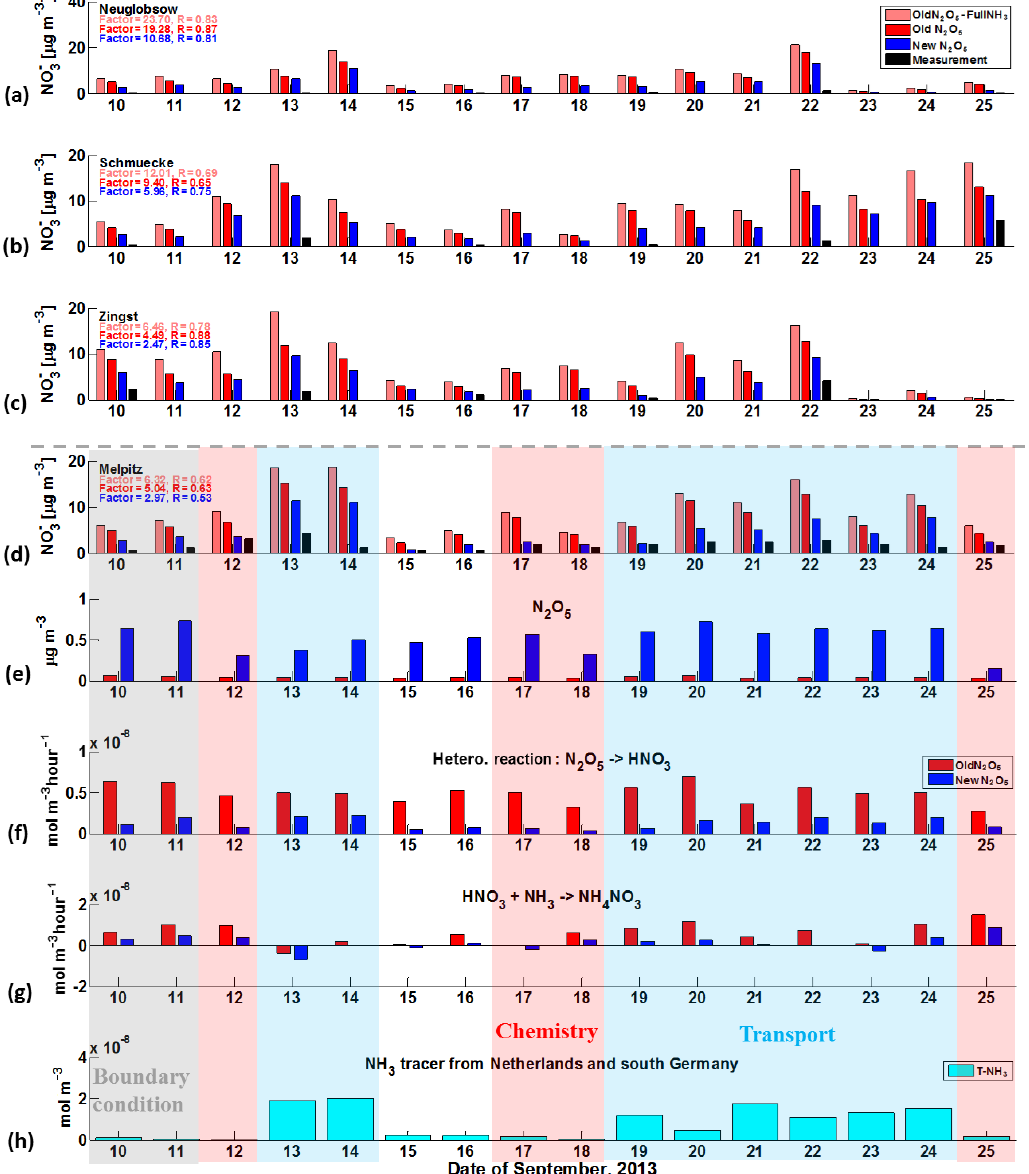
Figure 3. Comparison of particulate nitrate mass concentration between filter measurements and modelled results: (a) Neuglob- sow; (b) Schmuecke; (c) Zingst; (d) Melpitz. Modelled concentrations at Melpitz: (e) N 2 O 5 ; (f) marker species T1 for chemical reaction R1; (g) marker species for the chemical formation of particulate nitrate (T3-T2); (h) the NH 3 marker tracer (T-NH3) for transport from the Netherlands and southern Germany. The light-red colour bars indicate the results of the OldN2O5-FullNH3 case, the red colour bars indicate the results of the OldN2O5 case, and the blue colour bars indicate the results of the NewN2O5 case. The shaded periods indicate the dominating processes for high concentrations of particulate nitrate: chemical formation (red), transport (blue), and boundary conditions